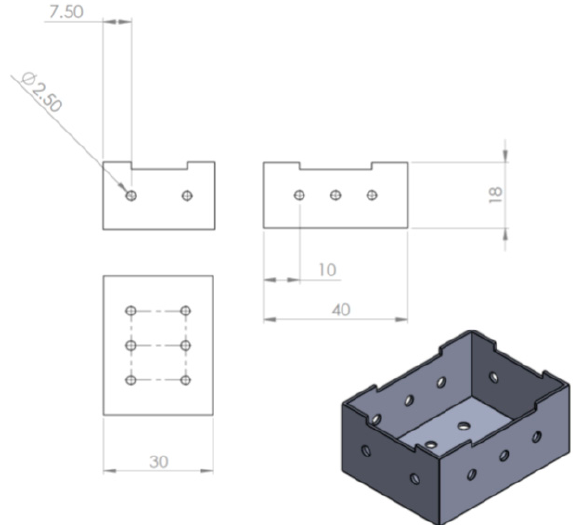
Figure 3. Illustration of the generic box geometry used to define the spatial extent of the representative elemental volume (REV) of produce. All units are in centimeters (cm). Fifty pieces of produce are packed inside the box to develop the REV.